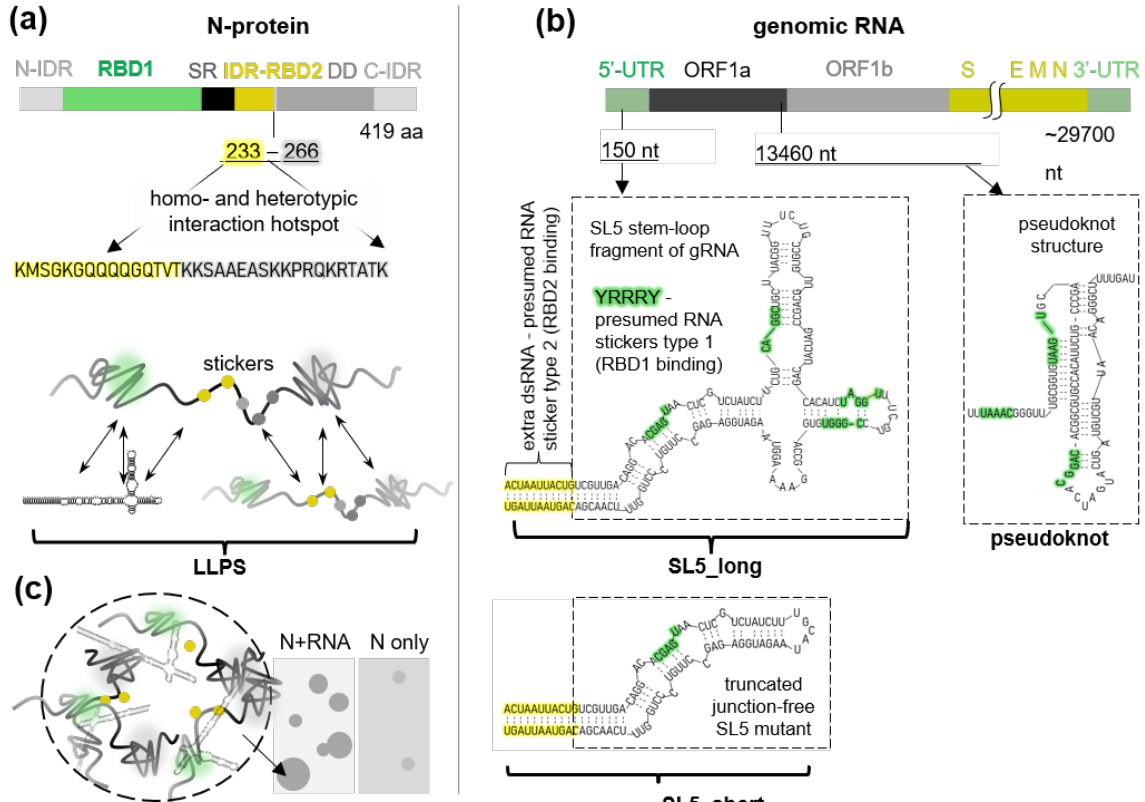
Figure 1. Schematic representation of the SARS-CoV-2 N protein ( a ) and gRNA fragments ( b ) used to model SARS-CoV-2 biomolecular condensates ( c ). Presumed RNA secondary structures are shown and presumed interaction hotspots (RNA stickers) are marked.